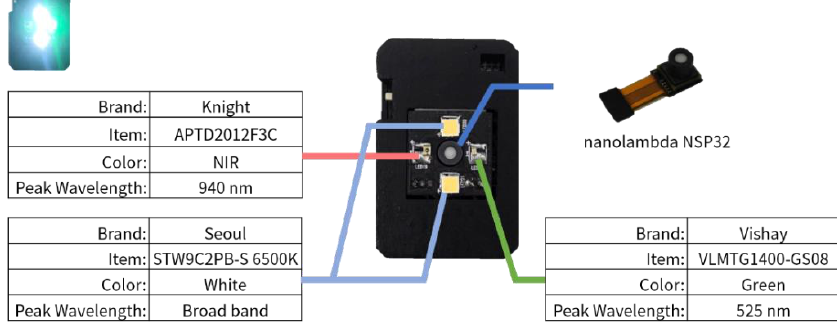
Figure 5. Light source specs and configuration.